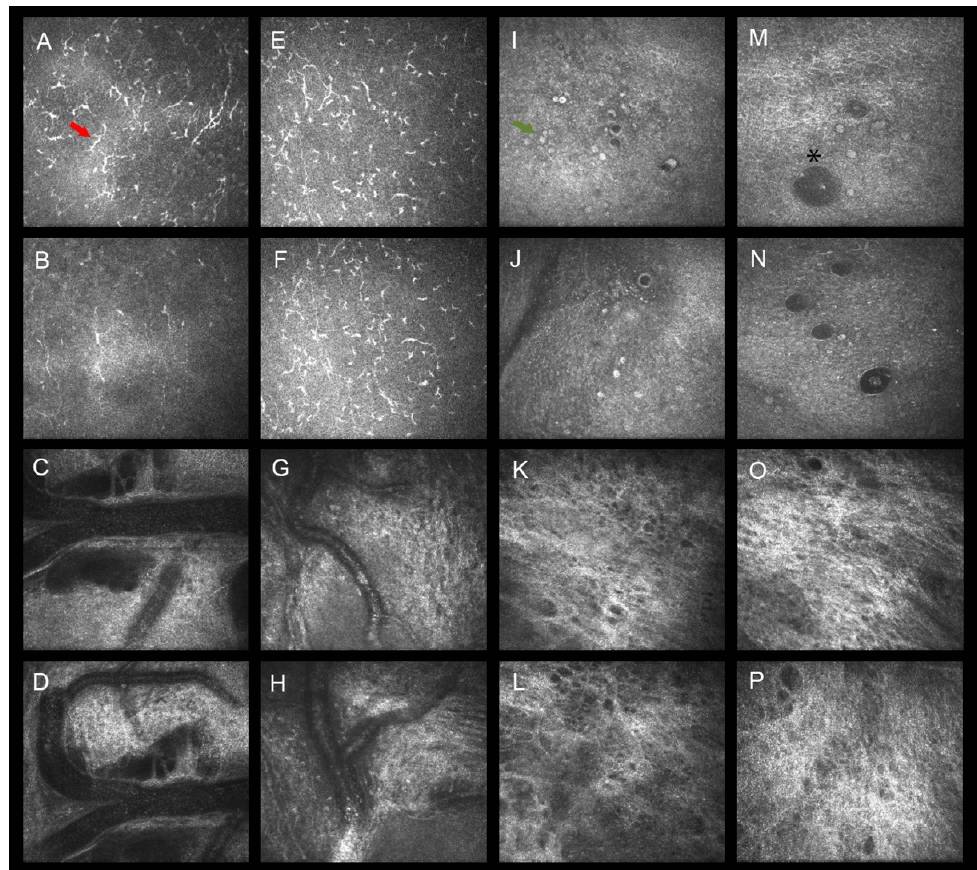
Figure 3. Baseline and post-treatments confocal frames of the conjunctival epithelium and stroma in representative patients that received topical fluorometholone ( A – D , I – L ; Group 1) or lubricants ( E – H , M – P , Group 4). Compared to baseline ( A ), fluorometholone significantly reduced sub-epithelial DCs (red arrow) four weeks after treatments ( B ), whereas lubricants did not ( E , F ). Epithelial GCs (green arrow) did not change their baseline density neither in patients receiving steroids ( I , J ) nor in controls ( M , N ) with an intra-epithelial conjunctival microcyst surrounded by goblet cells recognizable (asterisk, M ). The baseline vessel tortuosity did not change after steroid ( C , D ) or lubricant ( G , H ) treatments. The stromal meshwork reflectivity presented a mild reduction compared to baseline in patients receiving fluorometholone ( K , L ) while this was not observed in patients receiving lubricants ( O , P ).